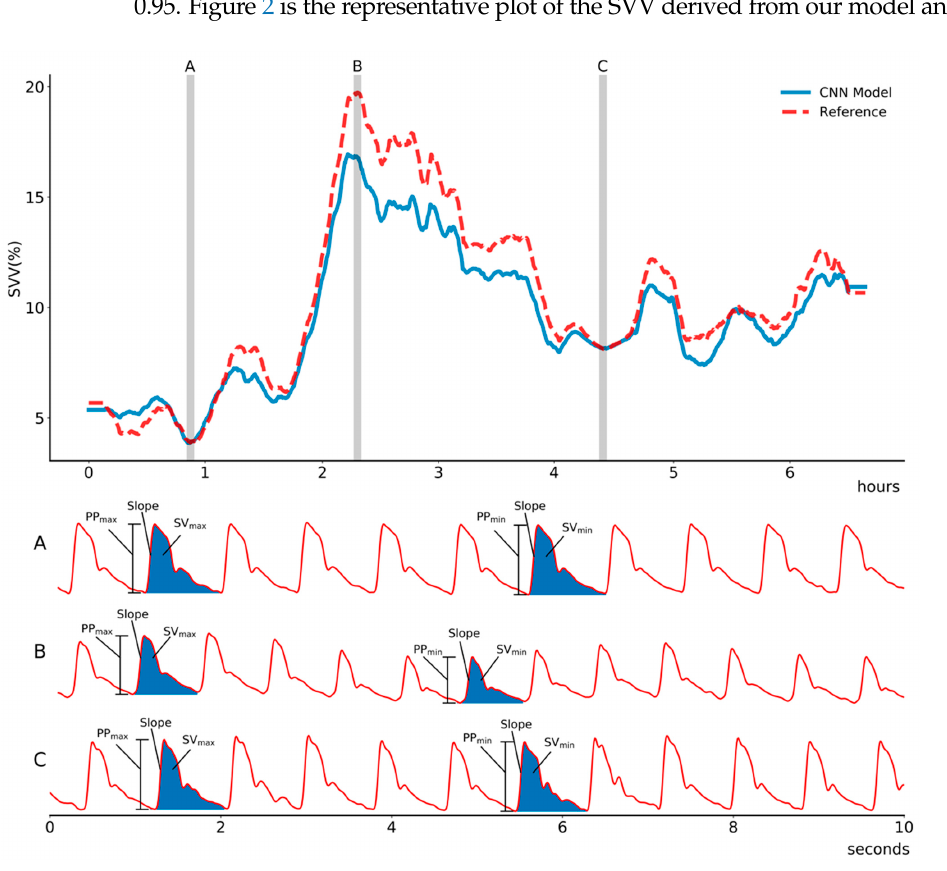
Figure 2. Representative plot of estimated stroke volume variance (SVV) using the proposed convolutional neural network model compared with that of a reference (EV1000, Edward, LifeScience) in ( A ) stable phase, ( B ) hypovolemic state due to massive intraoperative bleeding, and ( C ) recovery phase during intraoperative period. The proposed model shows high correlation to the reference value. Abbreviation: PP max , maximum pulse pressure during one ventilation cycle; PP min , minimum pulse pressure during one ventilation cycle; SV max , maximum stroke volume during one ventilation cycle; SVmin, minimum stroke volume during one ventilation cycle.